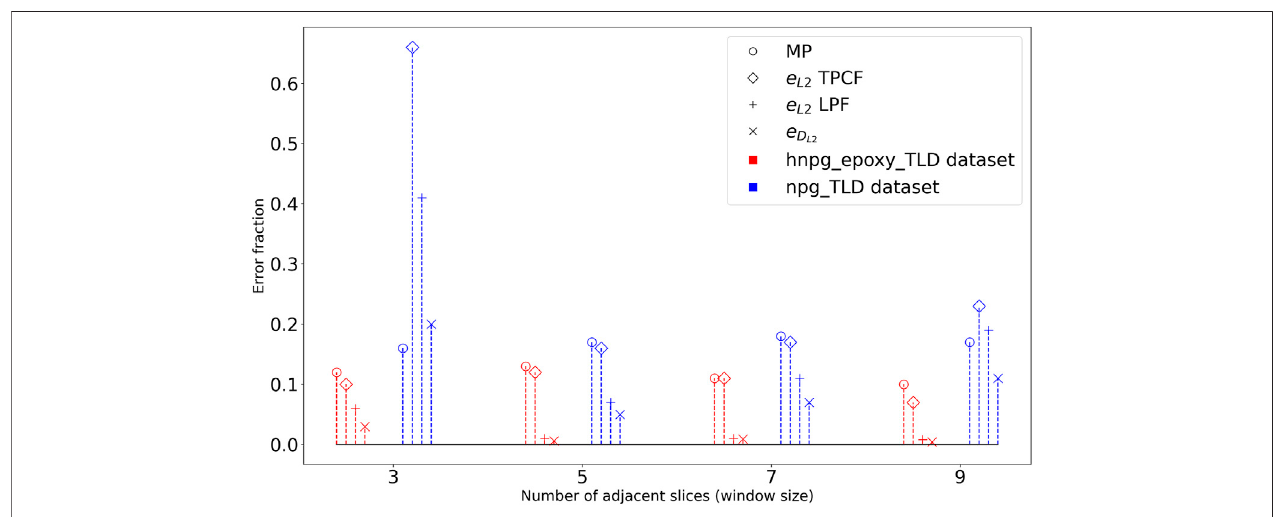
FIGURE 8 | Effect of window size when using 2D CNNs with adjacent slices for segmentation for the real datasets from Table 5 .